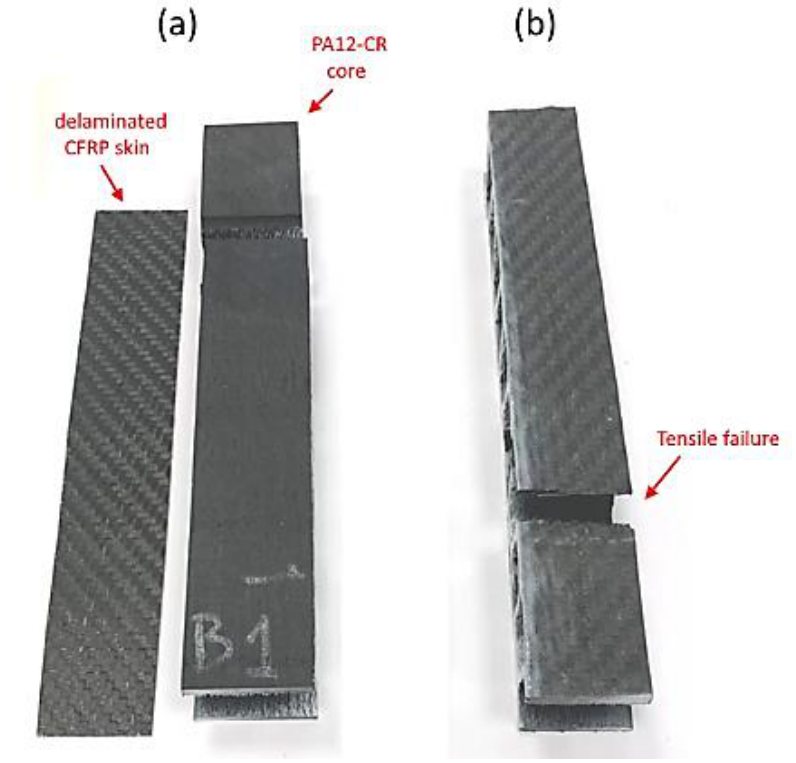
Figure 11. Failure modes of sandwiches: ( a ) delamination failure of UT specimen and ( b ) tensile failure of EP_P_1L specimen.